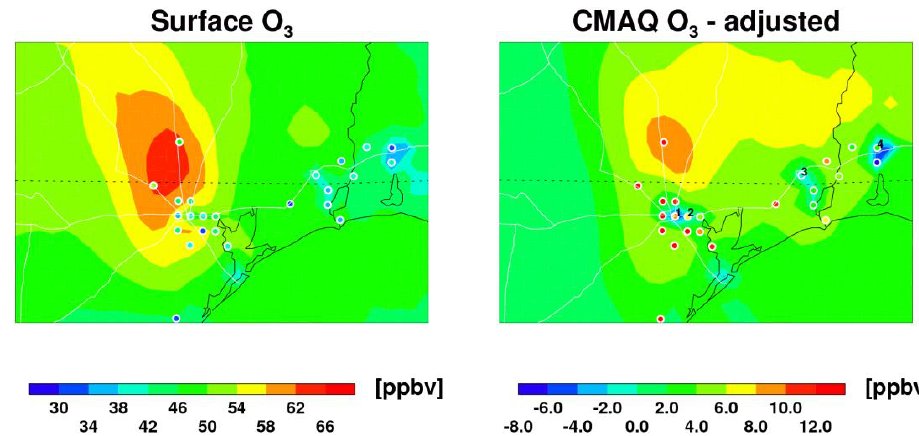
Fig. 9. The differences between the O 3 concentrations from a baseline CMAQ with baseline emissions, BASE2009 (left panel) and EPA Figure 9. The differences between the O concentrations from a baseline CMAQ with baseline AQS measurements (circles on the left panel); the differences between surface O 3 of the baseline CMAQ with BASE2009 and CMAQ with 3 GOME-2-adjusted NO x emissions, GOME2009 (right panel); and the differences between surface O 3 of the baseline CMAQ with BASE2009 and EPA AQS (circles on the right panel, baseline CMAQ simulations – EPA AQS observations) for the daytime (13:00–17:00LT) of August emissions, BASE2009 (left panel) and EPA AQS measurements (circles on the left panel); the of differences between surface O of the baseline CMAQ with BASE2009 and CMAQ with 3 GOME-2-adjusted NO emissions, GOME2009 (right panel); and the differences between x surface O of the baseline CMAQ with BASE2009 and EPA AQS (circles on the right panel, 3 baseline CMAQ simulations - EPA AQS observations) for the daytime (1-5PM, LT) of August of 2009.